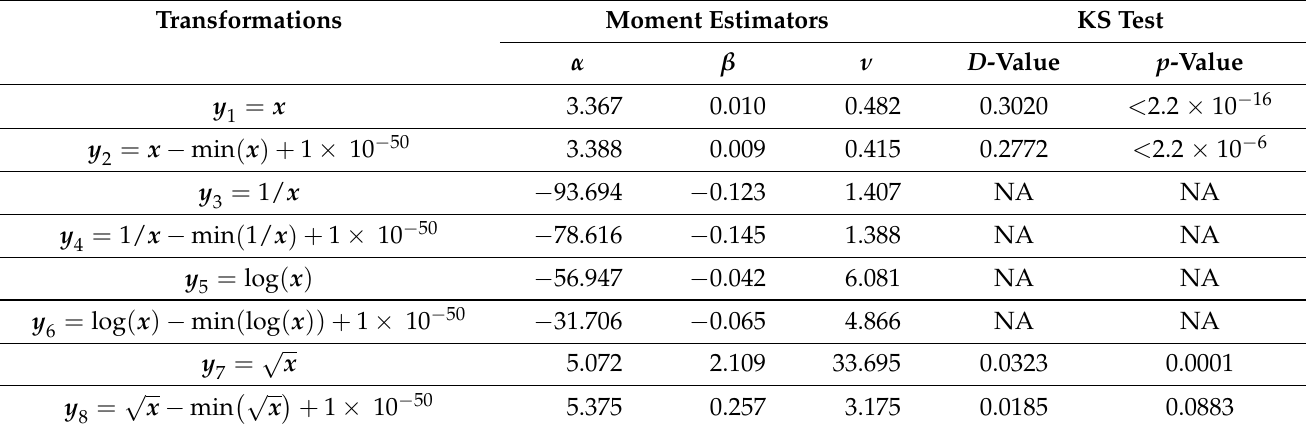
Table 5. The transformations, the moment estimators of the hyperparameters of the marginal density m 1 ( x | α , β , ν ) , and the D -value and p -value of the KS test.